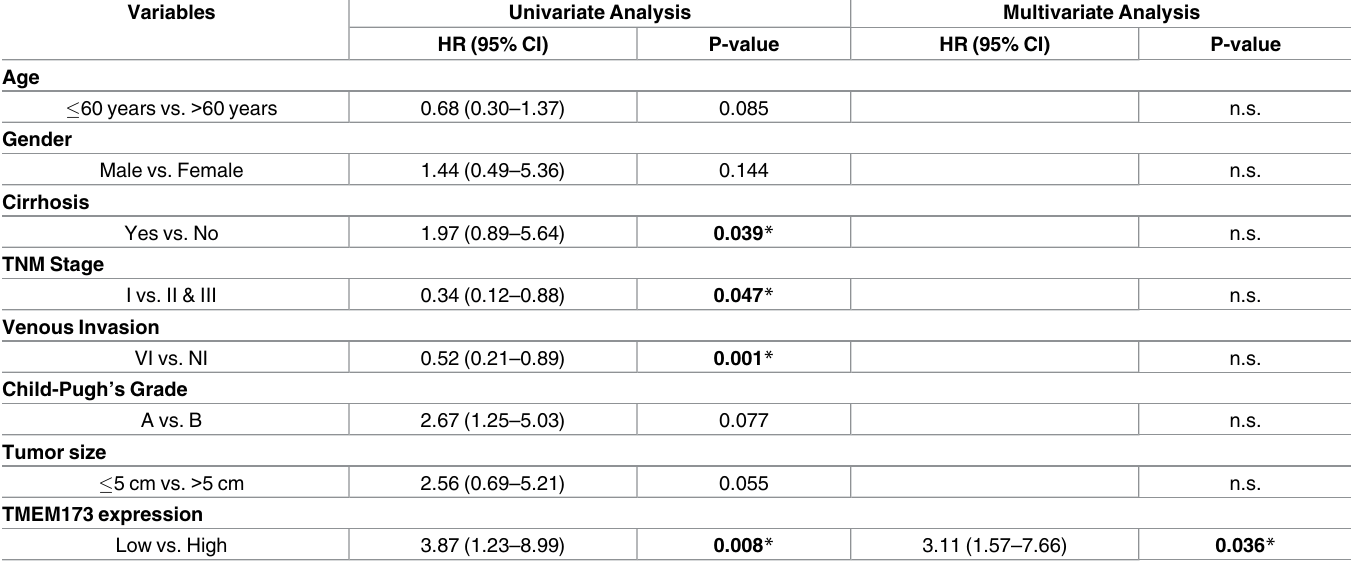
Table 2. Univariate and multivariate Cox regression analysis of clinicopathological characteristics influencing the overall survival of HCC